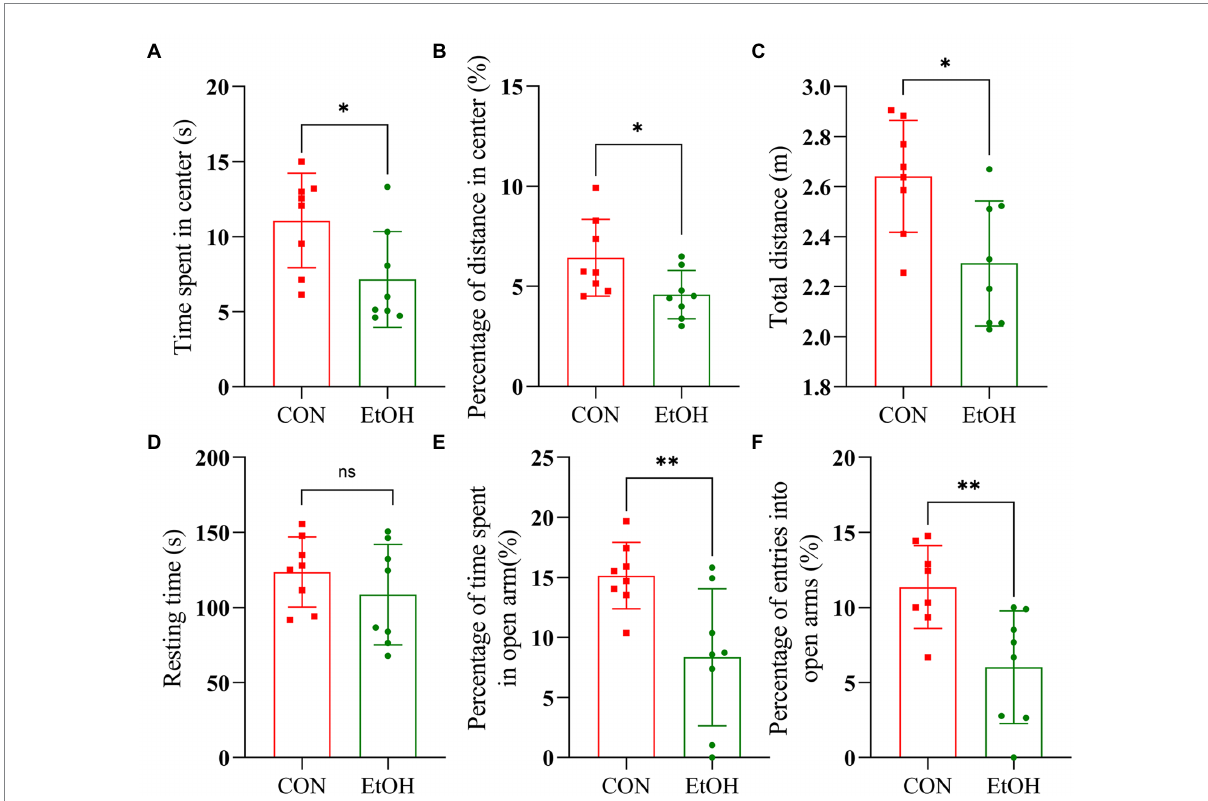
FIGURE 3 IA2BC rats exhibited anxiety-like behaviors. Behavior test was performed at the 28th day of the procedure. In the open field test, EtOH group rats spent less time in the center zone ( t = 2.47, p = 0.027), traveled significantly less distance in the center zone ( t = 2.30, p = 0.038) and less total distances ( t = 2.94, p = 0.011) than that of CON group (A–C) . The resting time between EtOH and CON group had no significant difference ( t = 1.04, p = 0.351, D ). In the elevated plus maze, the EtOH group spent less time in open arms ( t = 3.04, p = 0.009) and the number entries into open arms significantly reduced ( t = 3.24, p = 0.006) compared with CON group (E,F) . Results are displayed as means ± SD. Significant results were determined by unpaired t -tests, * p < 0.05, ** p <